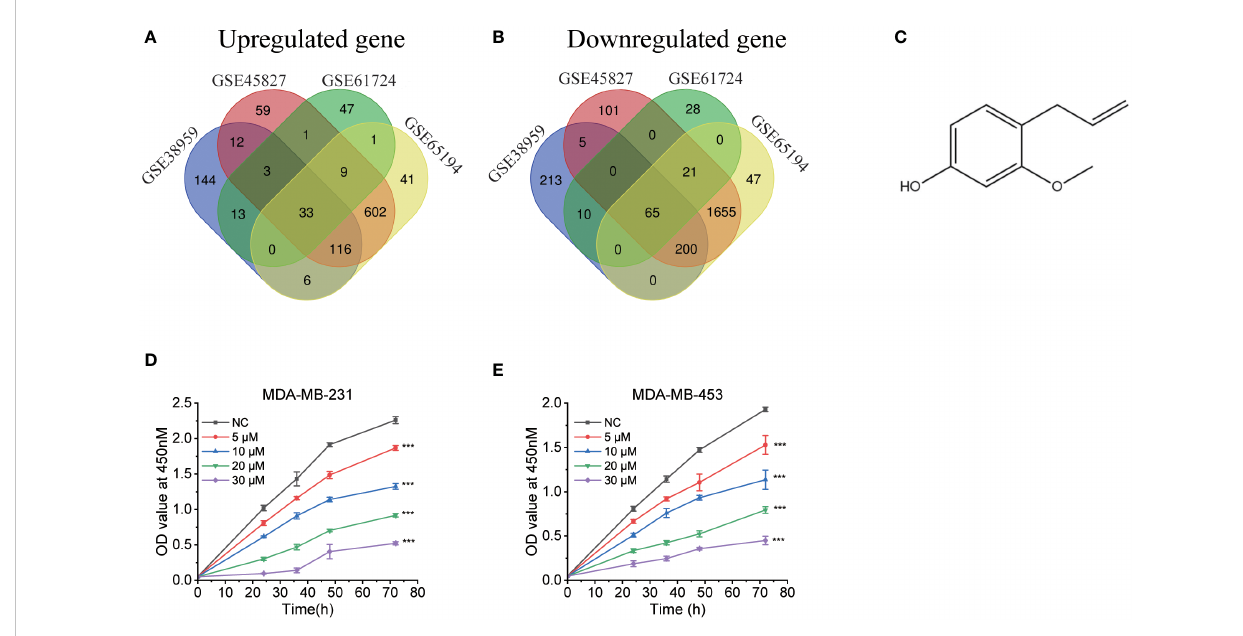
FIGURE 1 Bioinformatics analysis to explore the anti-tumor potential of eugenol. (A) The Venn diagram displays the information of distinct genes that are increased across four data sets (GSE45827, GSE38959, GSE61724, GSE65194) to query the CMap. (B) The Venn diagram displays the amount of downregulated different genes vis four data sets (GSE45827, GSE38959, GSE61724, GSE65194) to query the CMap. (C) The chemical structure of eugenol. (D, E) CCK8 assay of indicated MDA-MB-231 and MDA-MB-453 cells viability treated with eugenol (0-30 m M). Student ’ s t-test, n=3. ***P < 0.001.